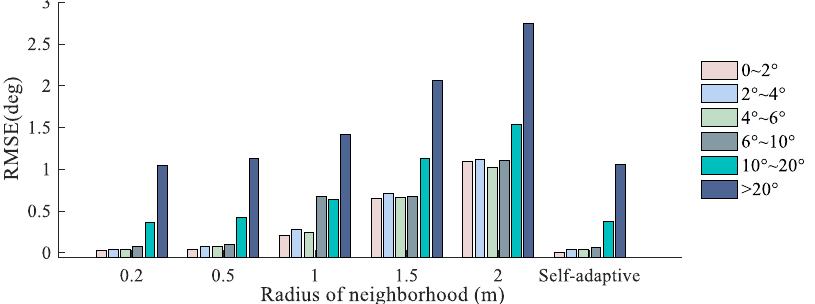
Figure 14. Accuracy of surface slope estimation with grades of slope value in different neighbor- hood point selection radii. Table 5. Root mean square error of wave surface slope estimation in different intervals.